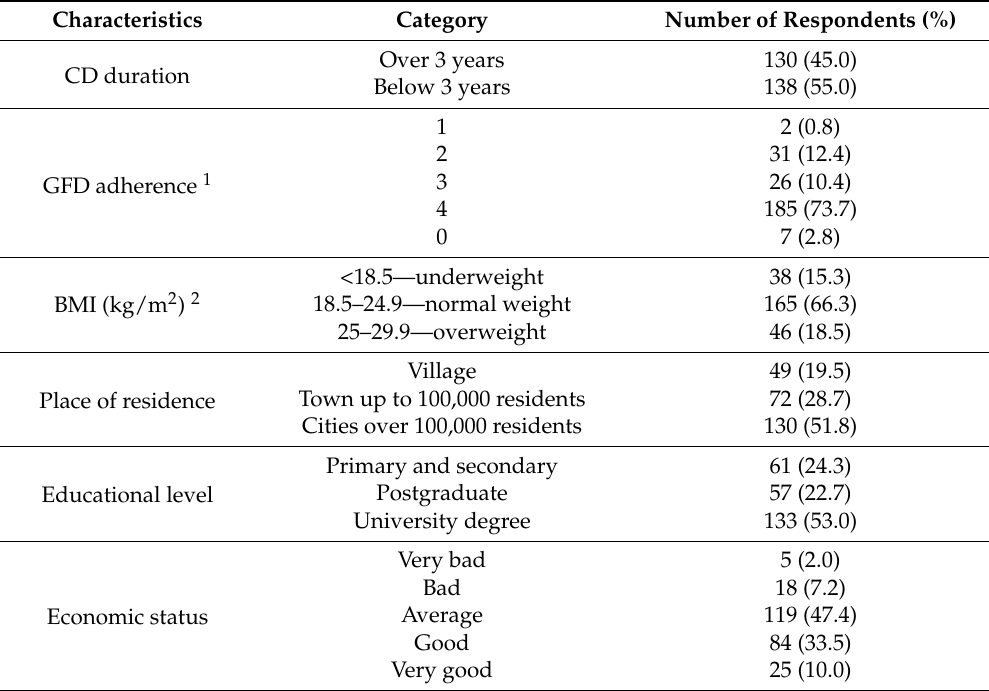
Table 1. Characteristics of the study sample ( n = 251).